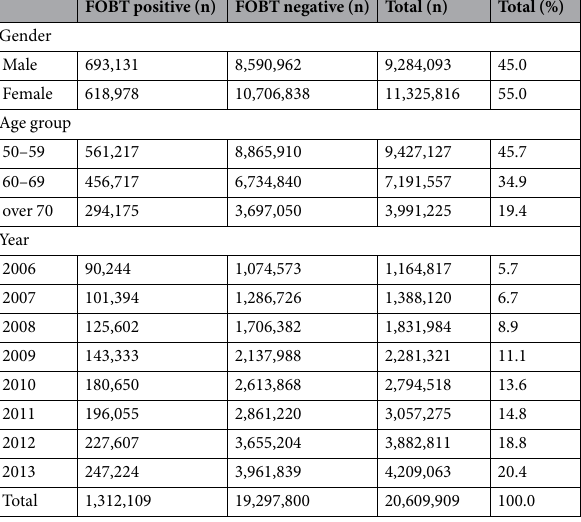
Table 1. Characteristics of study population among the Korea national colorectal cancer screening program during 8 years (2006–2013). Abbreviations: FOBT, fecal occult blood